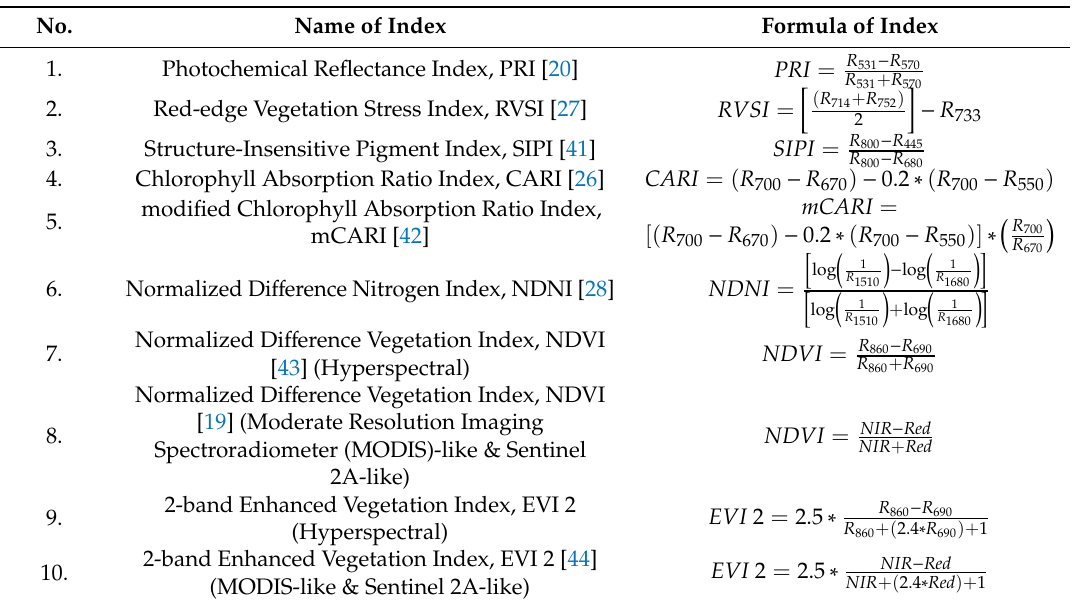
Table 2. Formulae of reported indices used in this